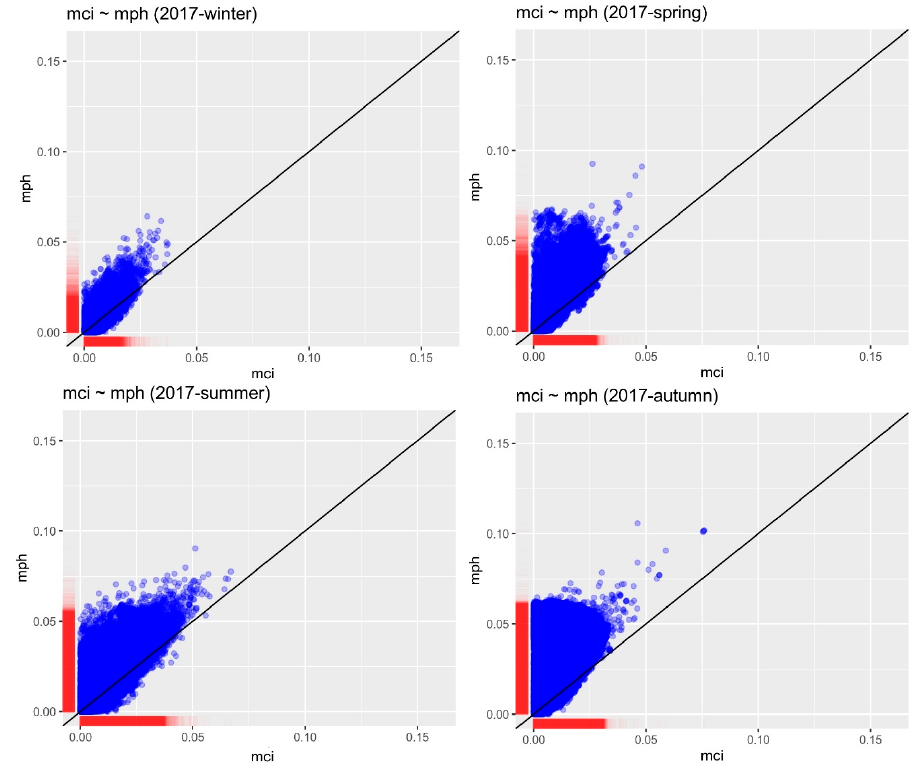
Figure A2. Scatter plot of MCI–MPH for the seasons of 2017.